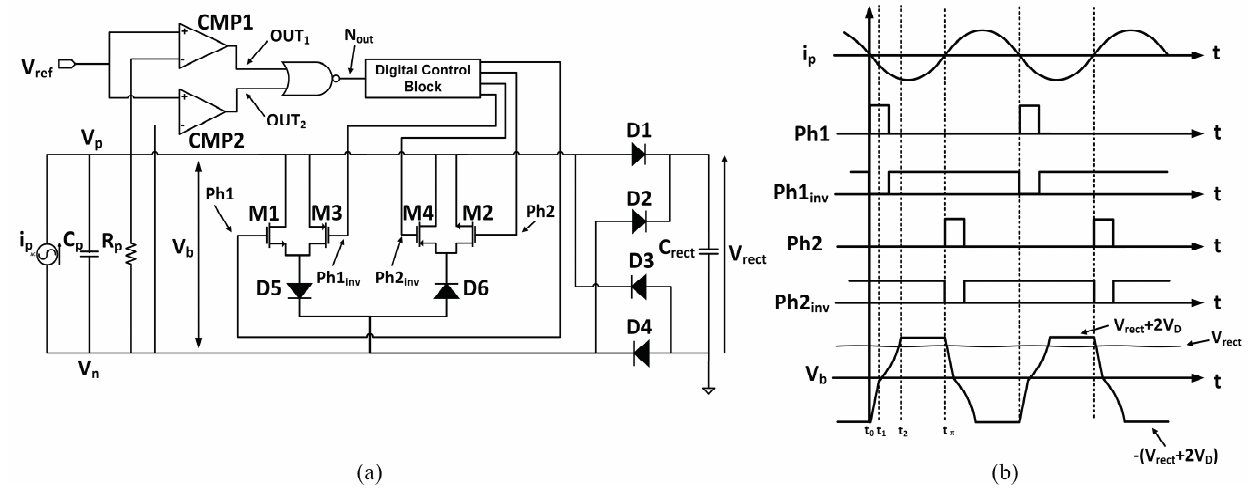
Figure 6. ( a ) Implementation of proposed self-controlled inductorless rectifier; ( b ) associated voltage and current